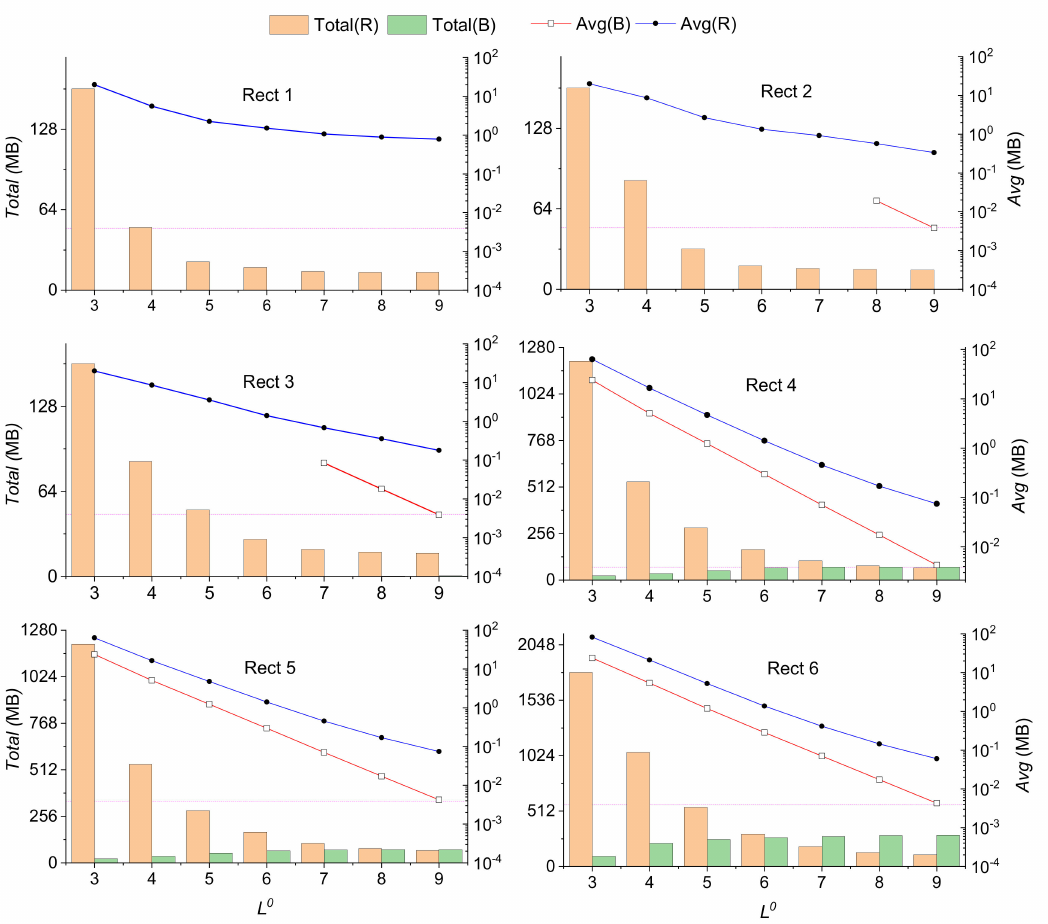
Figure 8. Total (Total) and average (Avg) sizes of the buckets (B) and R-trees (R) accessed during the region query by each rectangle. The horizontal dashed line in each subplot indicates the location of 4 KB on the right axis. For certain rectangles, the total size of the buckets is extremely small; thus, these buckets appear to be missing in the